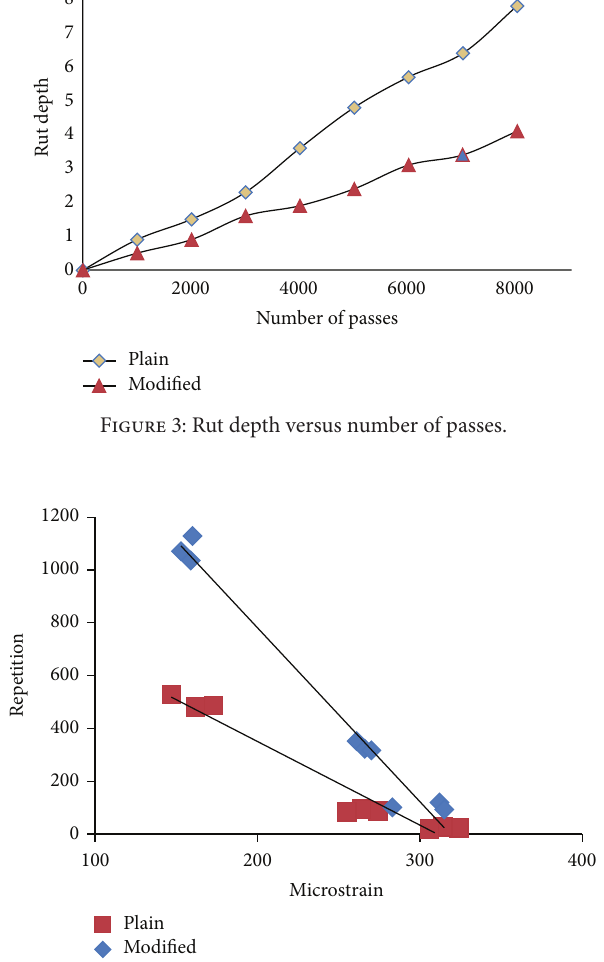
Figure 4: Tensile strain versus number of